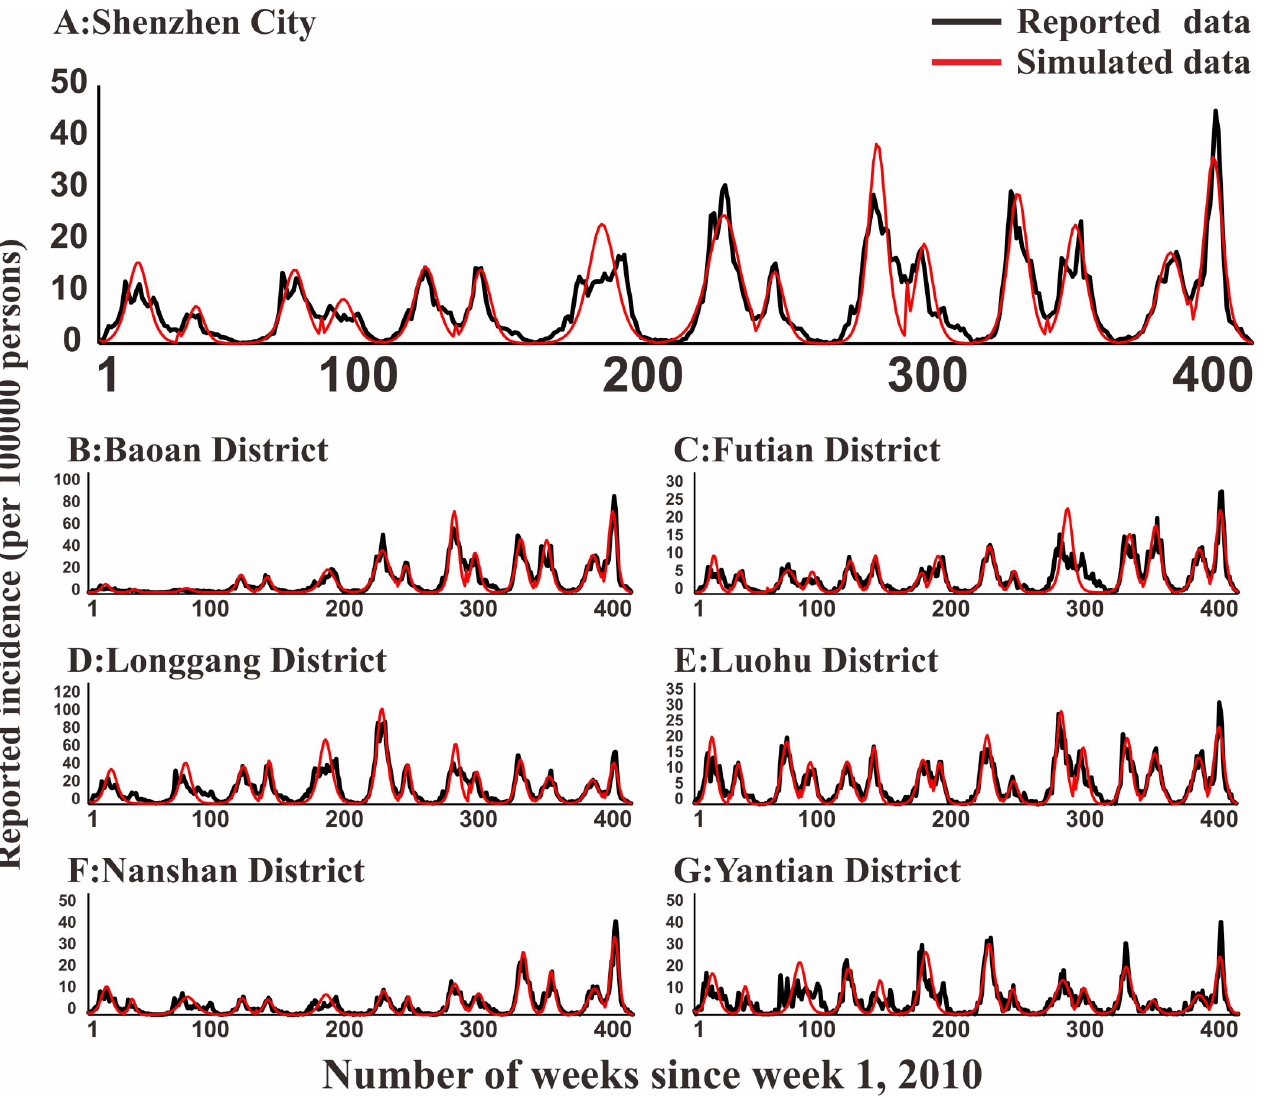
Fig 7. Epidemics of HFMD and LDE model fittings within ShenZhen City and its 6 districts. (A: Shenzhen City; B: Baoan District; C: Futian District; D: Longgang District; E: Luohu District; F: Nanshan District; G: Yantian